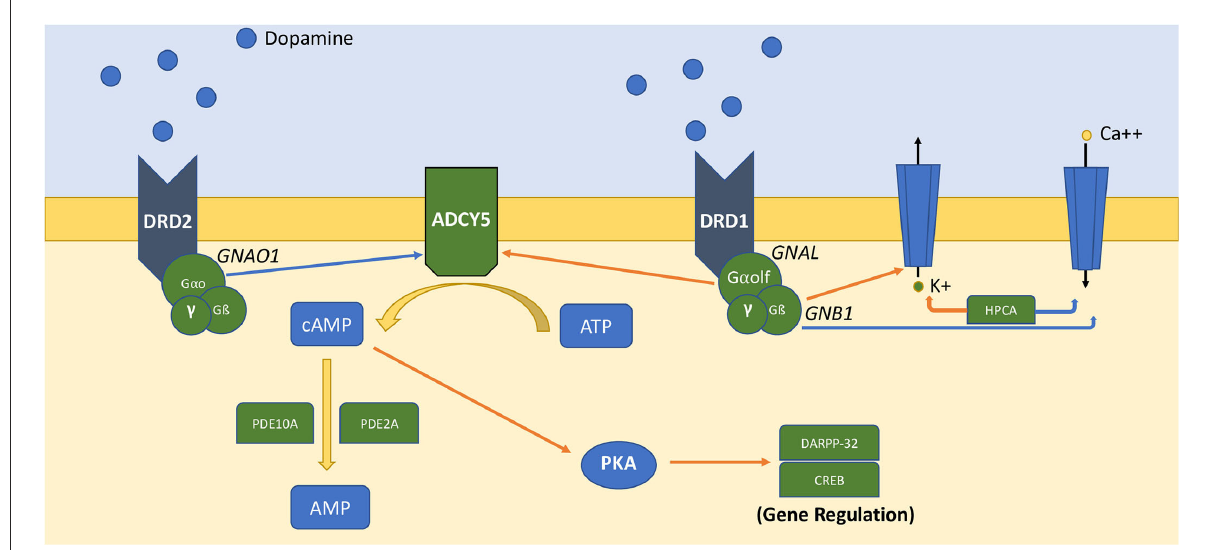
FIGURE1 Simplified representation of DA-dependent GPCRs–cAMP signaling pathway in medium spiny neurons. Orange arrows represent activation signals, and blue arrows represent inhibitory signals. ATP is converted to AMP by adenyl-cyclase-5 (ADCY5), which is regulated by G α o ( GNAO1 ) and G α olf ( GNAL ). Gß subunit ( GNB1 ) and hippocalcin (HPCA) regulate the activity of potassium and calcium channels. The generated cAMP propagates downstream signaling via cAMP-binding proteins. cAMP is converted to AMP by phosphodiesterase activity (PDE10A,